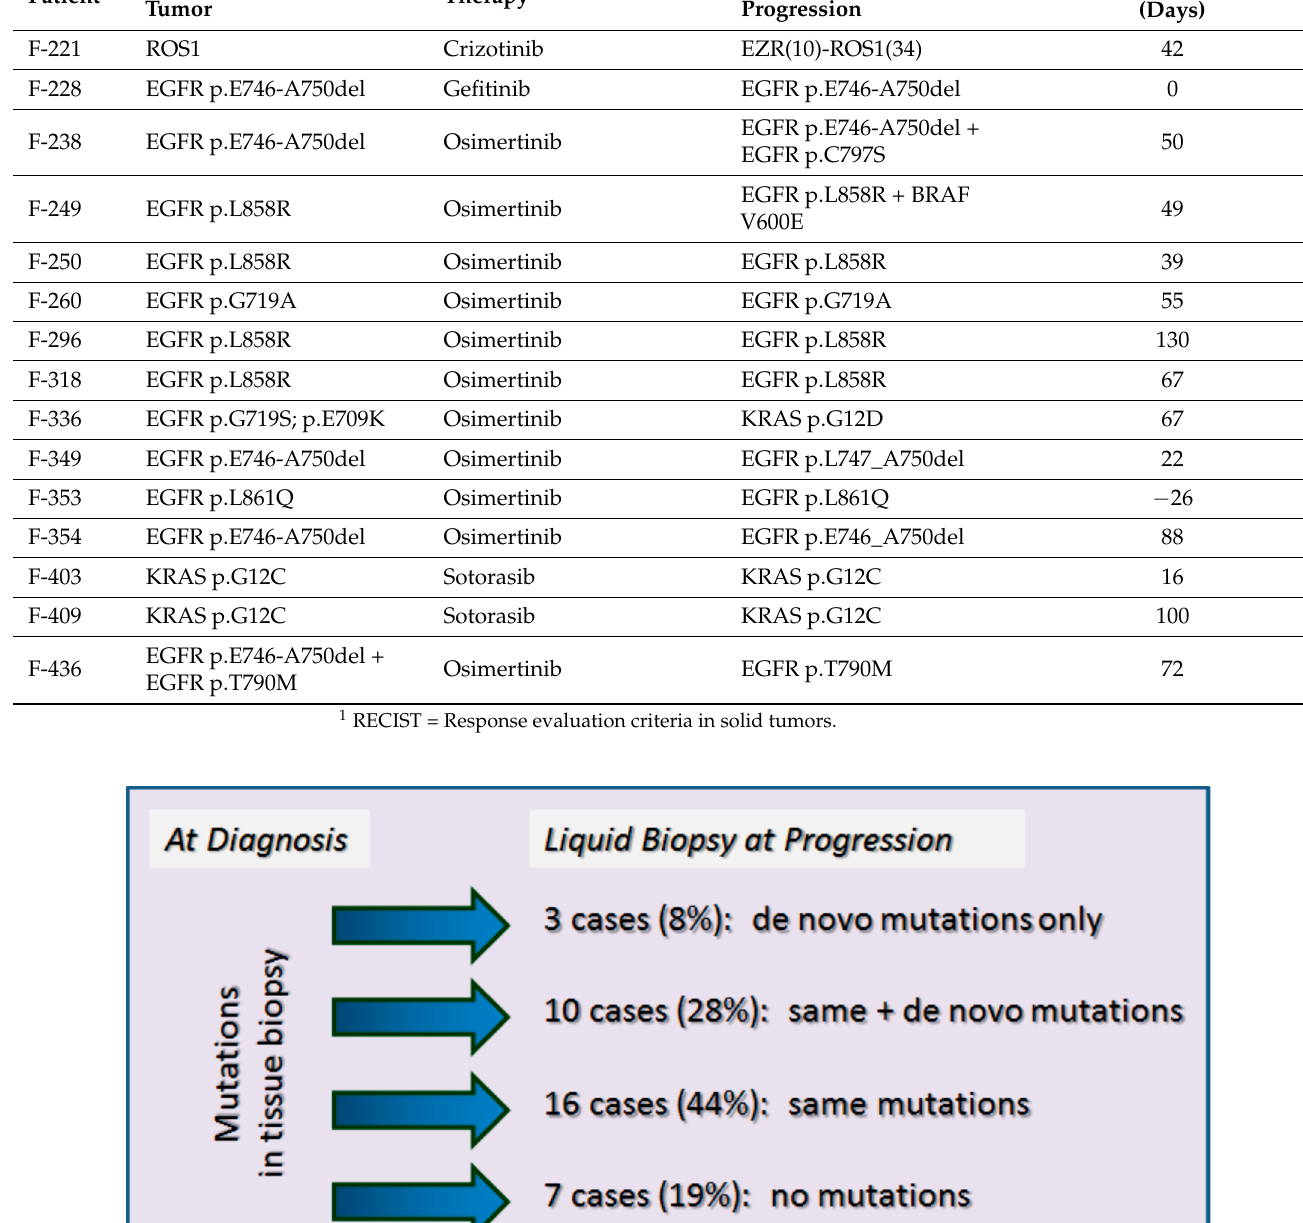
Figure 2. Detection of disease progression according to RECIST or by reappearance of ctDNA. X- axis represents the time (days) from 1 July 2018 (start of liquid biopsy sample collection) or the day of first diagnosis (if after 1 July 2018). Median progression “survival” was 375 days on RECIST and 249 days on ctDNA. Based on the Gehan–Breslow–Wilcoxon test, the two curves are significantly different ( p = 0.04).